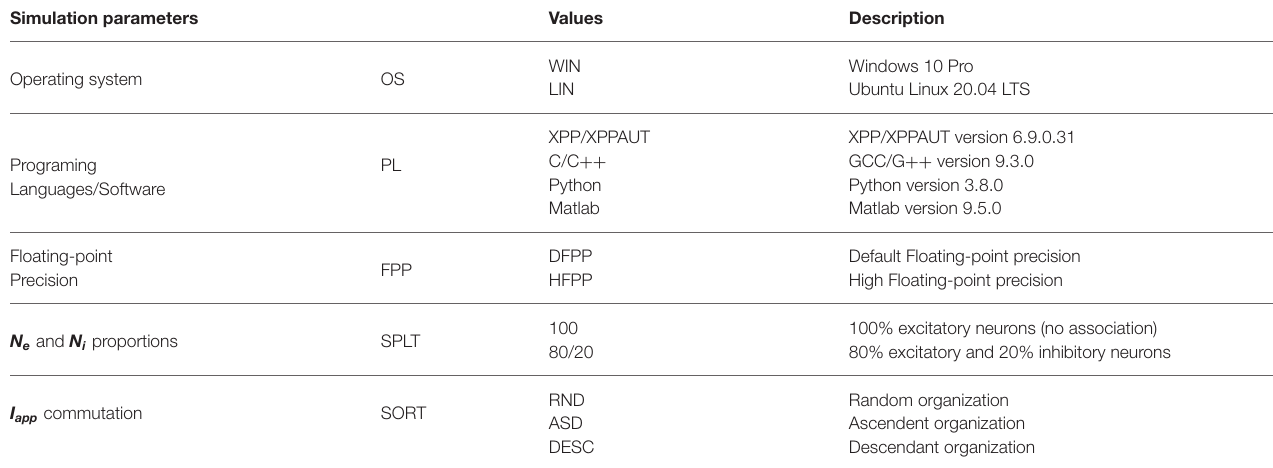
TABLE 2 | Simulation parameters.